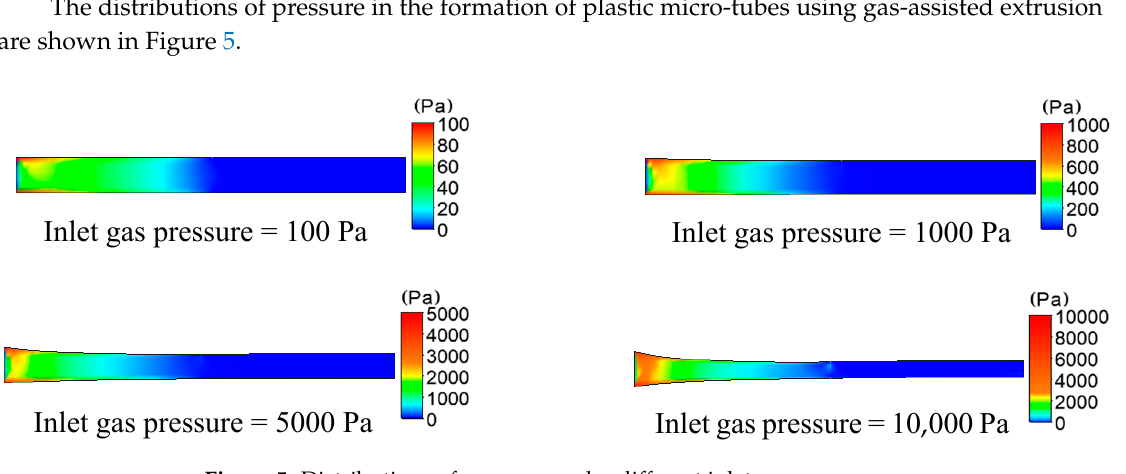
Figure 5. Distributions of pressure under different inlet gas pressures.